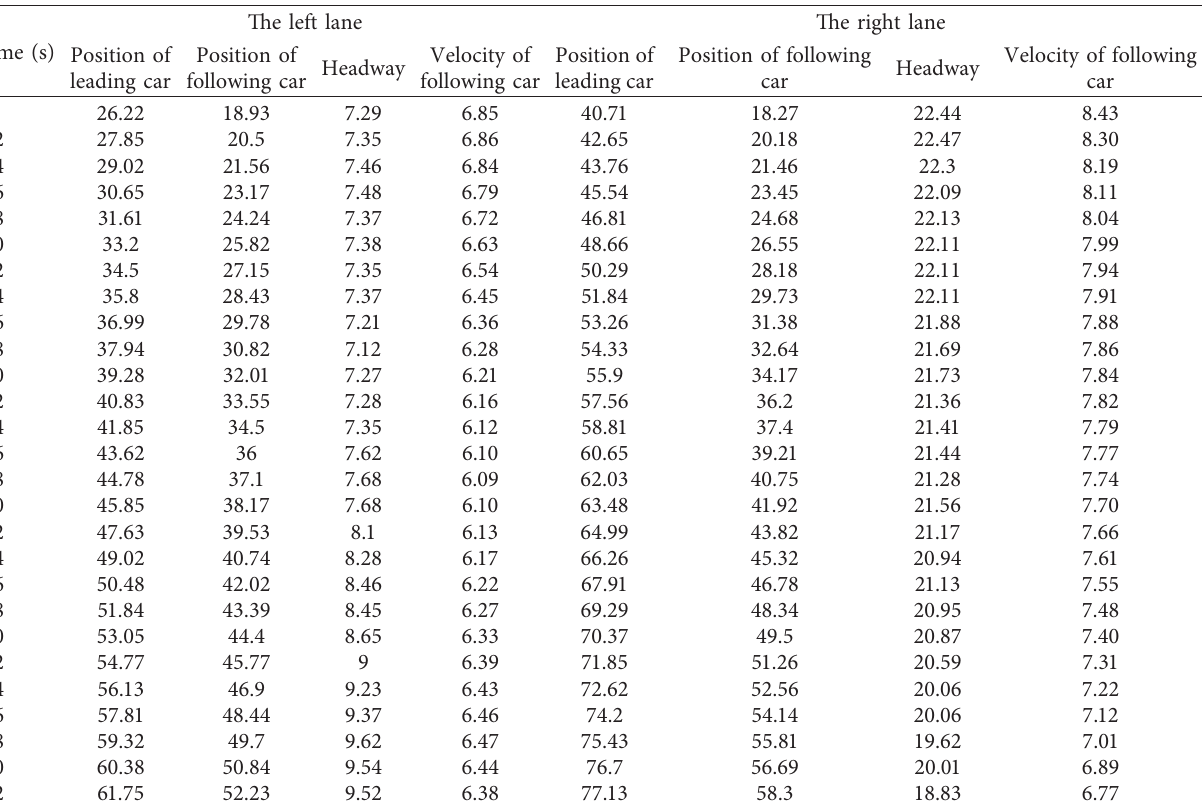
Table 2: The first sets of vehicle data.